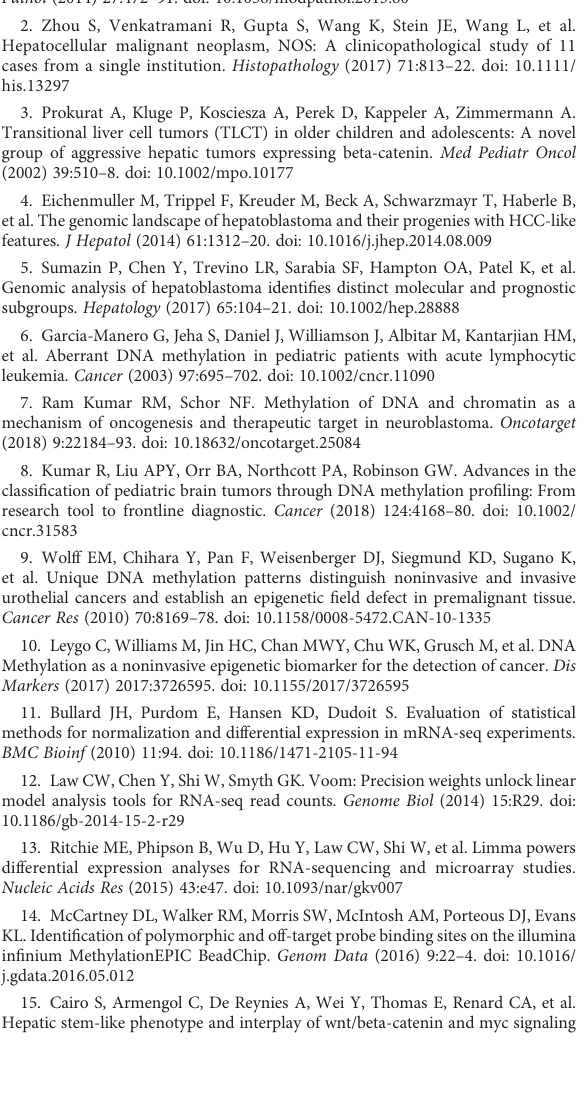
liver controls. (C) Box plots of 9 potential DNA CpG island methylation- regulated genes in HCC. The gene expression of HAND2, CES4A, SORBS1, GADD45B and C14orf180 were all signi fi cantly downregulated while SP6, SRC, MAZ and TCF3 were all signi fi cantly upregulated in HCC tumors compared to the normal